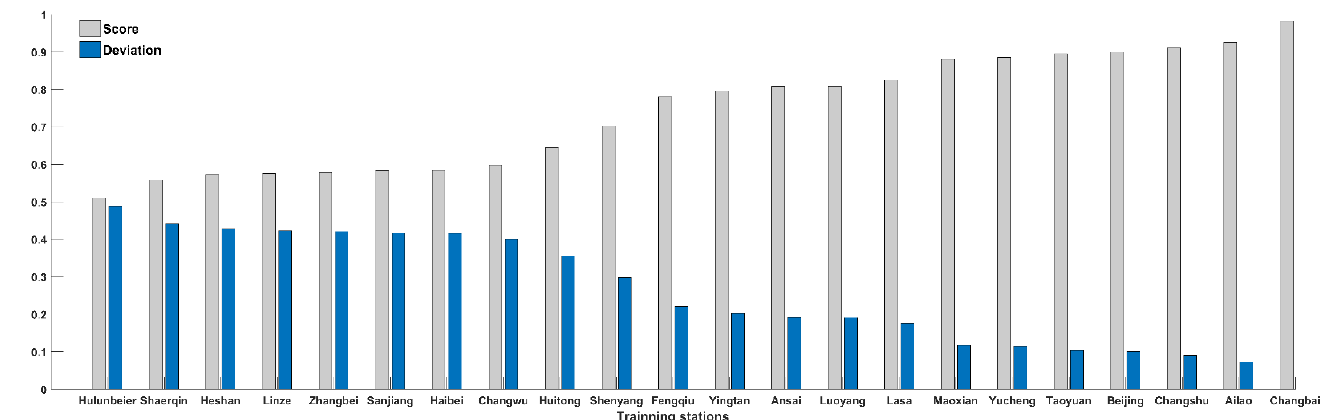
Figure 4. The regression deviation and score of the training stations by DSS-LPV: the blue histogram represents the deviation between the regression value and target of training stations; the grey histogram represents the score of training stations.